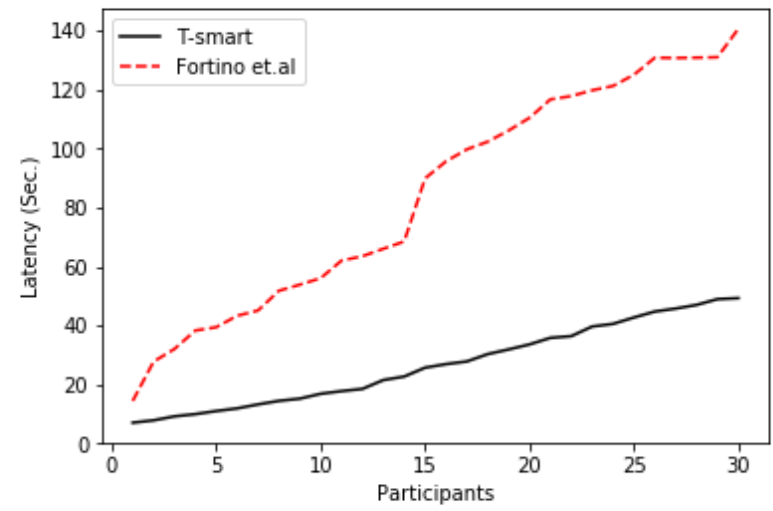
Figure 10. Average transaction